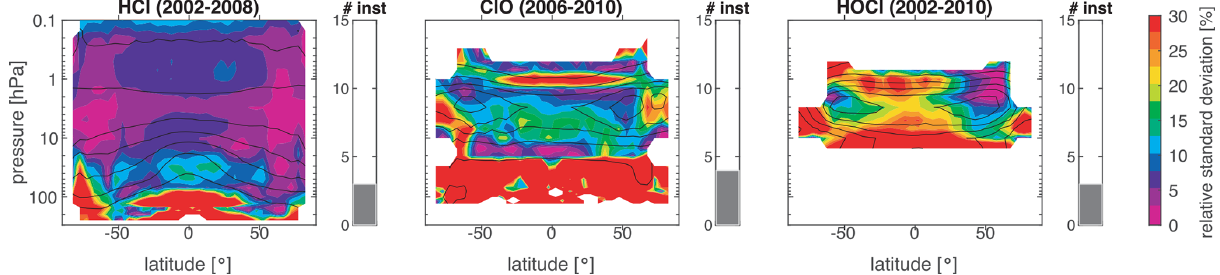
Figure 17. Same as Fig. 14 but for chlorine-containing species. The assessment of the uncertainty in the annual mean state is based on ClO daytime and HOCl nighttime datasets. Note that for ClO, the dataset from SMR is included which has been derived by scaling the individual measurements with a chemical box model to 13:30LST. See SPARC (2017) for more detailed